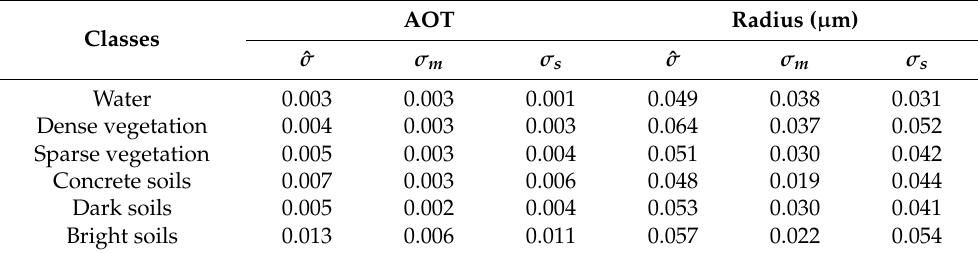
Table 6. Mean standard deviations of the posterior uncertainties ˆ σ in AOT and modal radius by surface categories. The uncertainty from the measurement σ m and from the resolving error component σ s are associated with this standard